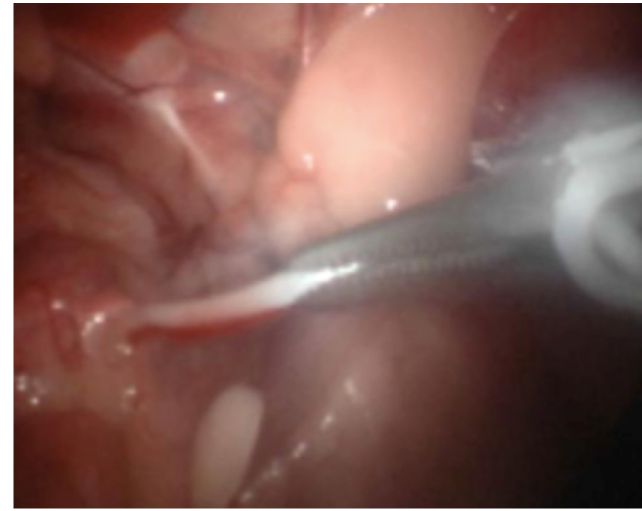
Figure 3. Image of the laparoscopic surgery showing the coagulation of vas deferens.